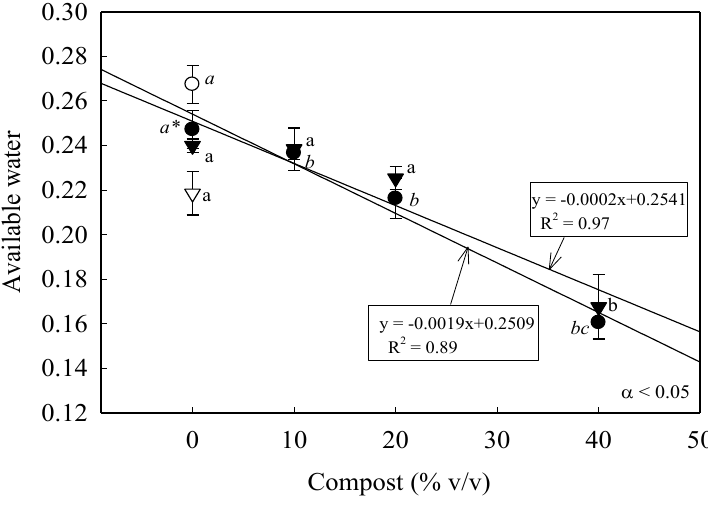
Figure 3. Effect of incorporating composted poultry litter into top 12.7 cm of subsoil on available water, A for ● sodded compost; ○ sodded fertilizer; ▼ seeded compost; and v seeded fertilizer plots; * Means with same letters are statistically insignificant based on Fisher’s Protected LSD test ( P ≤ 0.05) (italicized statistics correspond to sodded